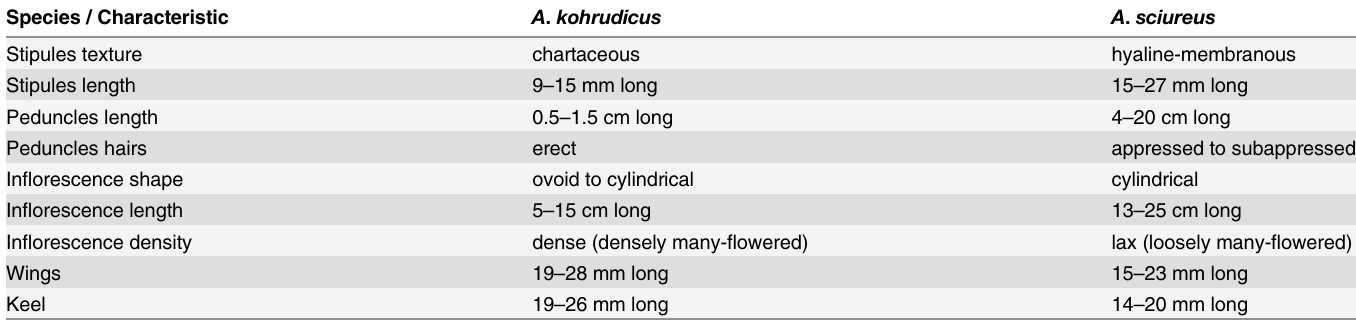
Table 3. Differences between Astragalus kohrudicus (including A . sciureus var. subsessilis ) compared to A . sciureus